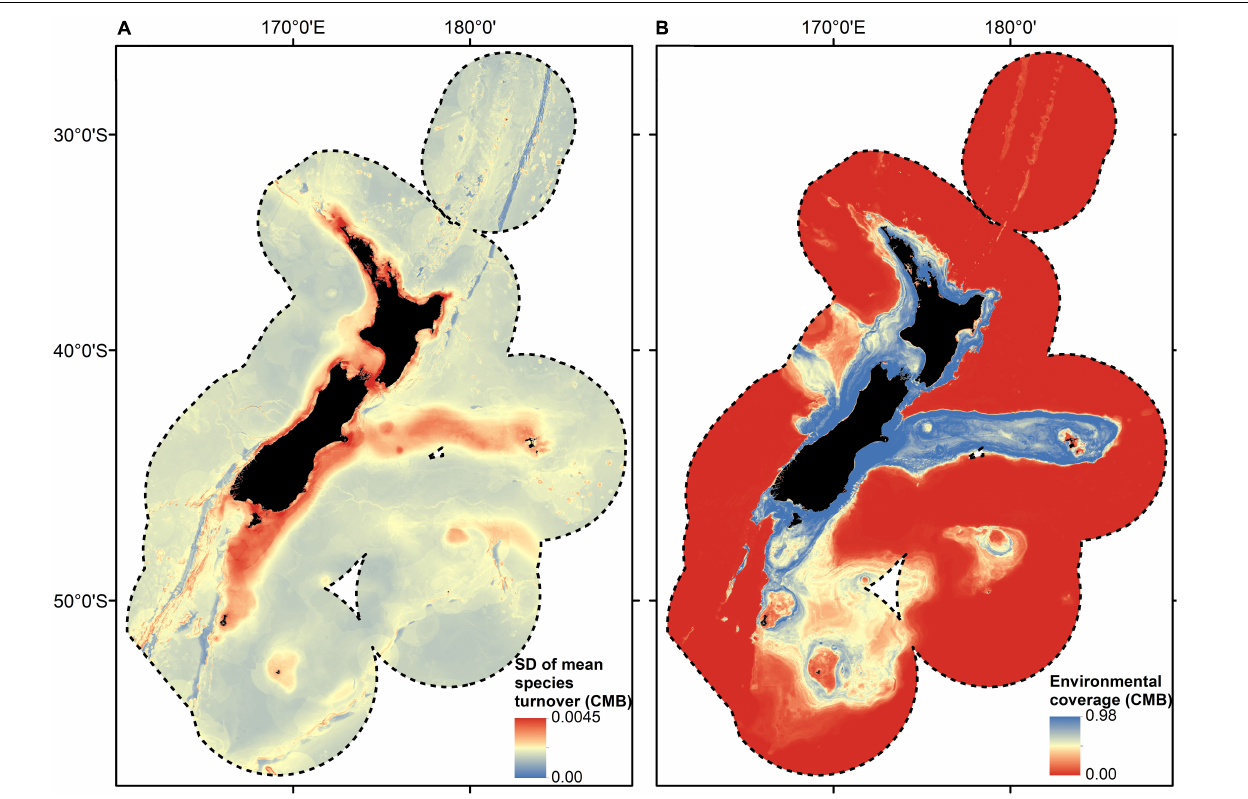
FIGURE 3 | Spatially explicit estimate of uncertainty and environmental coverage from the combined bootstrapped Gradient Forest model fitted using samples from all biotic groups. Uncertainty estimate (SD) of compositional turnover modelled using bootstrapped Gradient Forest model fitted with demersal fish, benthic invertebrate, macroalgae and reef fish samples (A) . Predicted environmental coverage depicting the confidence that can be placed in the predictions, ranging from low (i.e., no samples in the dataset with those environmental conditions) to high (i.e., many samples with those environmental conditions) within the New Zealand marine environment (B) . See Figure 1 for feature